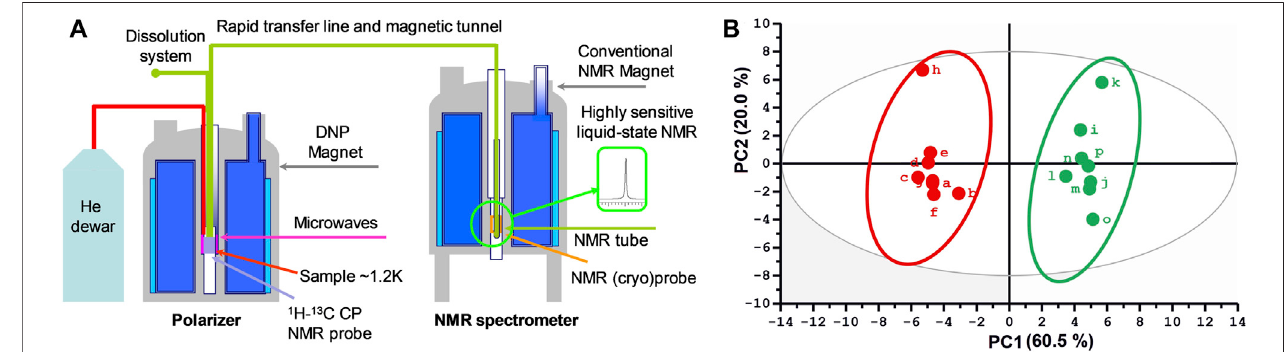
FIGURE 6 | Potential of dissolution dynamic nuclear polarization (d-DNP) for highly sensitive 13 C NMR metabolomics at natural abundance. (A) d-DNP experimental scheme, where the sample is fi rst hyperpolarized at liquid He temperature in a glass-forming solvent by microwave irradiation of free radicals, then rapidly transferred through a magnetic tunnel to a classical NMR spectrometer where conventional detection occurs. (B) First application of this experimental scheme in a natural abundance 13 C metabolomics study, reported in 2020 by Dey et al. Scores plot of the principal component analysis (PCA) obtained from 40 spectral buckets from hyperpolarized 13 C spectra of 16 tomato fruit extracts at different ripening stages (green vs red). Integrals were normalized to Na-TSP-d 4 as an internal reference and to the weight of the sample used for extraction. Mean centering and unit variance scaling were used in PCA. (B) Reproduced from (Dey et al.,